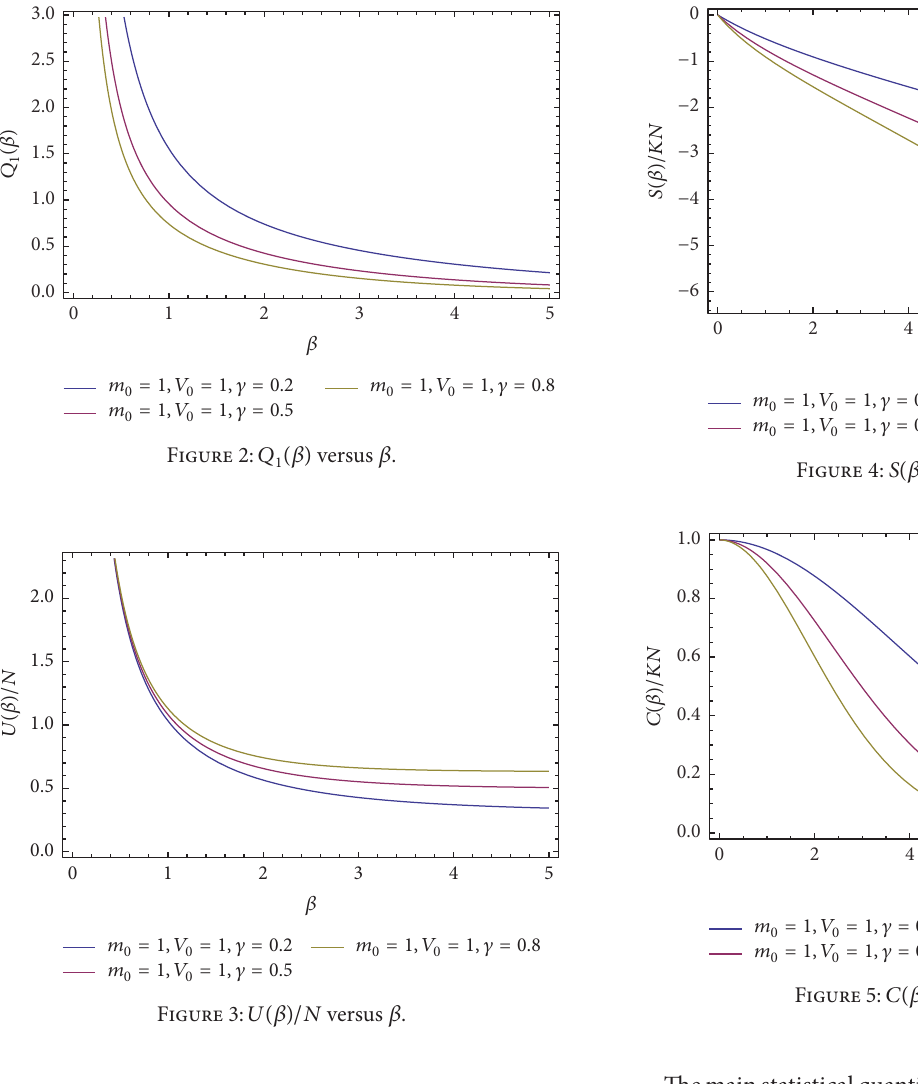
Figure 3: 𝑈(𝛽)/𝑁 versus 𝛽 .